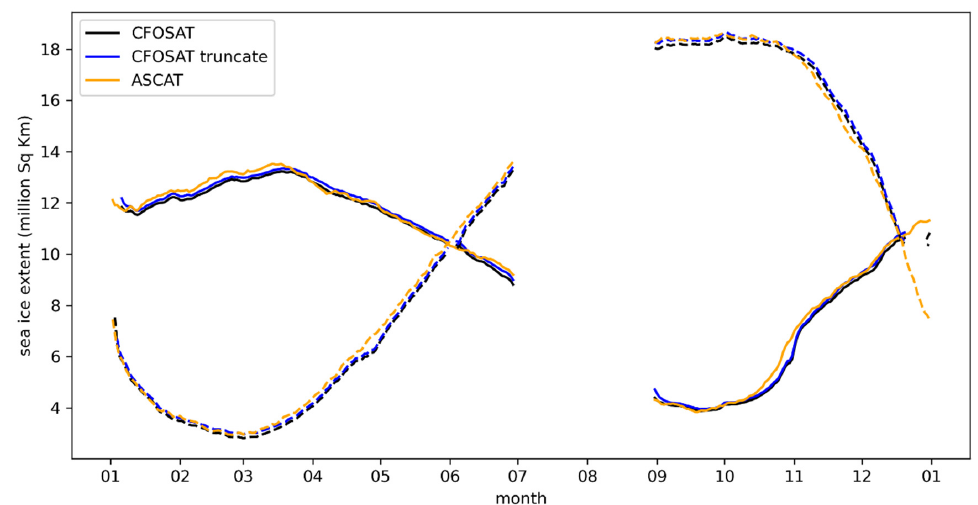
Figure 13. Daily Arctic (solid lines) and Antarctic (dashed lines) sea ice extents in 2019 from CFOSAT all_inc (black), CFOSAT truncated_inc (blue), ASCAT (orange), CSCAT instrument restart period is excluded here.